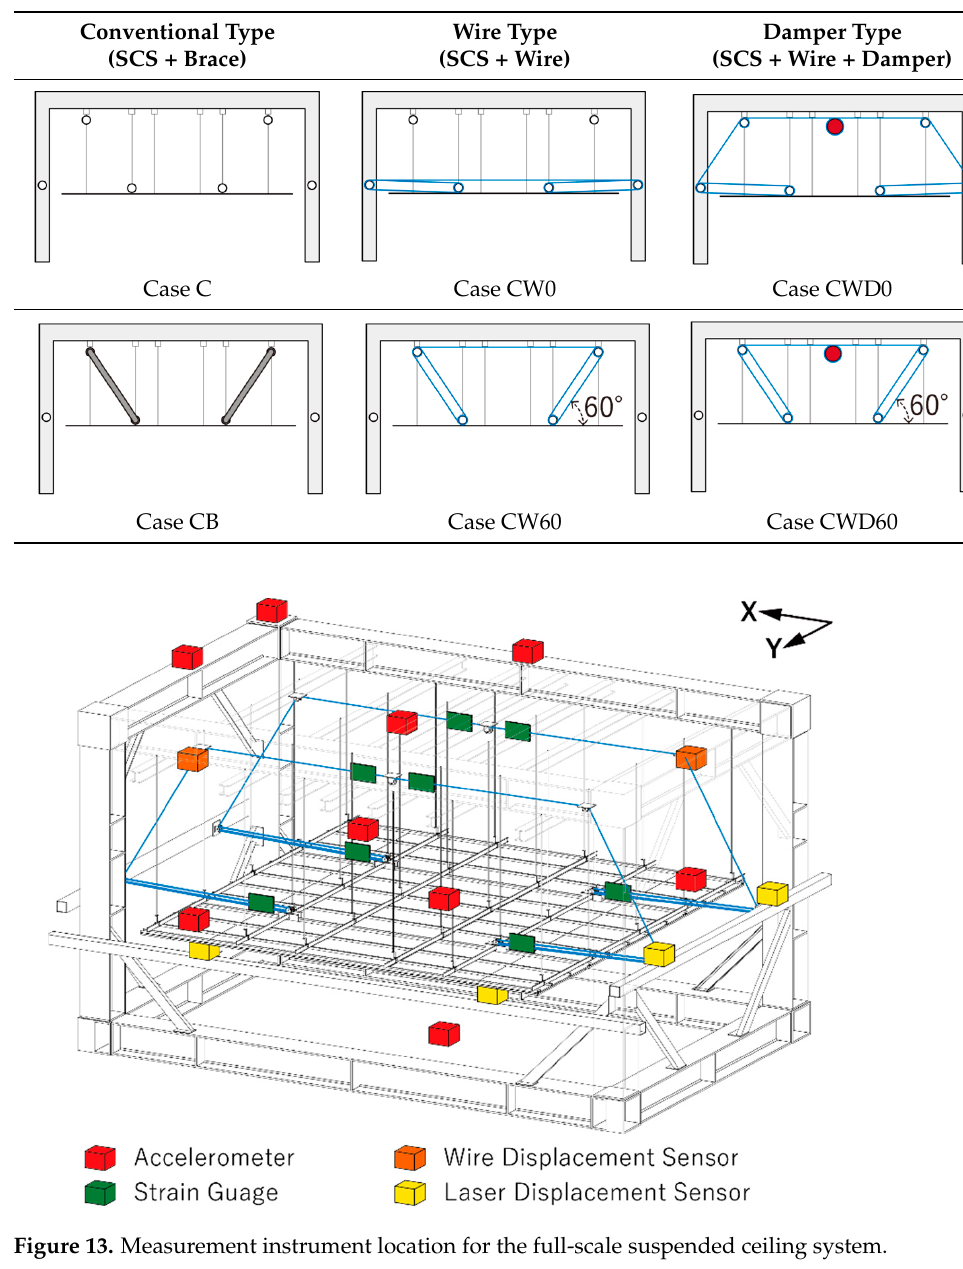
Table 2. Information on the SCS specimen.